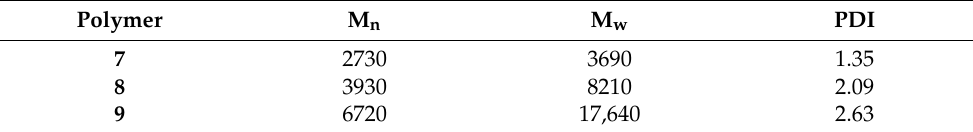
Table 1. Molecular weights and polydispersity indices (PDI) of the oligomers 7 – 9 .